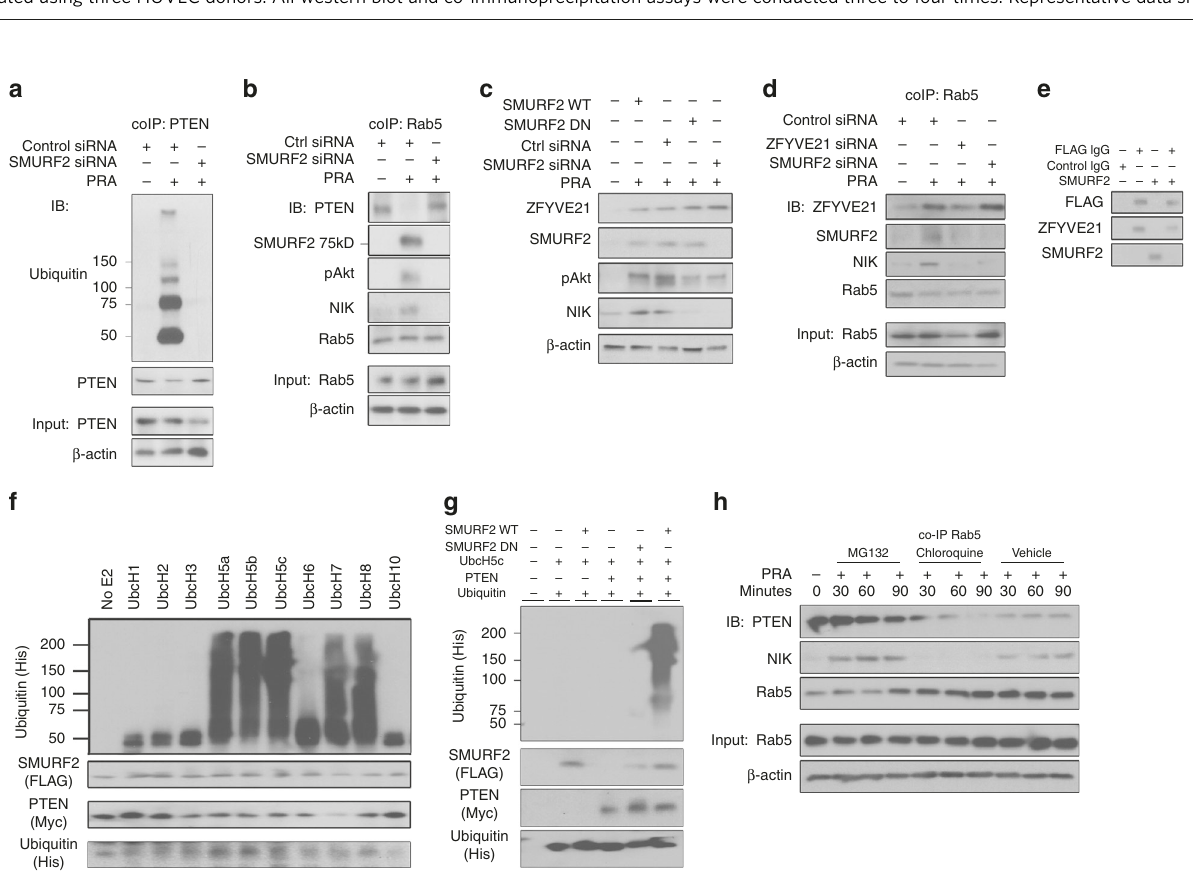
Fig. 2 ZFYVE21 modulates PI(3,4,5)P3 by vesicular removal of PTEN. Spectral counts of PTEN in vesicular proteomes ( a ). Human umbilical vein endothelial cells (HUVECs) transfected with control or PTEN siRNA were treated with panel reactive antibody (PRA) sera for 30 min prior to Rab5 co- immunoprecipitation and western blotting ( b , left) or with PRA sera for 4 h prior to quantitative reverse transcriptase PCR (qRT-PCR) analysis ( b , right). HUVECs stably transduced with Rab5 WT or Rab5 DN constructs were treated with PRA sera for 30 min prior to Rab5 co-immunoprecipitation ( c , left) or confocal microscopic staining ( c , right, left scale bar: 10 μ m, right scale bar: 342 nm). HUVECs were treated with PRA for 30 min prior to downstream analyses by Rab5 co-immunoprecipitation ( d ), confocal microscopic staining ( e , left scale bar: 10 μ m, right scale bar: 251 nm), and enzymatic assays assessing vesicular PTEN activity ( f ). Co-immunoprecipitation studies were performed as indicated ( g – i ). * p < 0.05, analysis of variance. Proteomic analyses were performed three times using three separate HUVEC donors. qRT-PCR analyses were performed using technical triplicates and was repeated